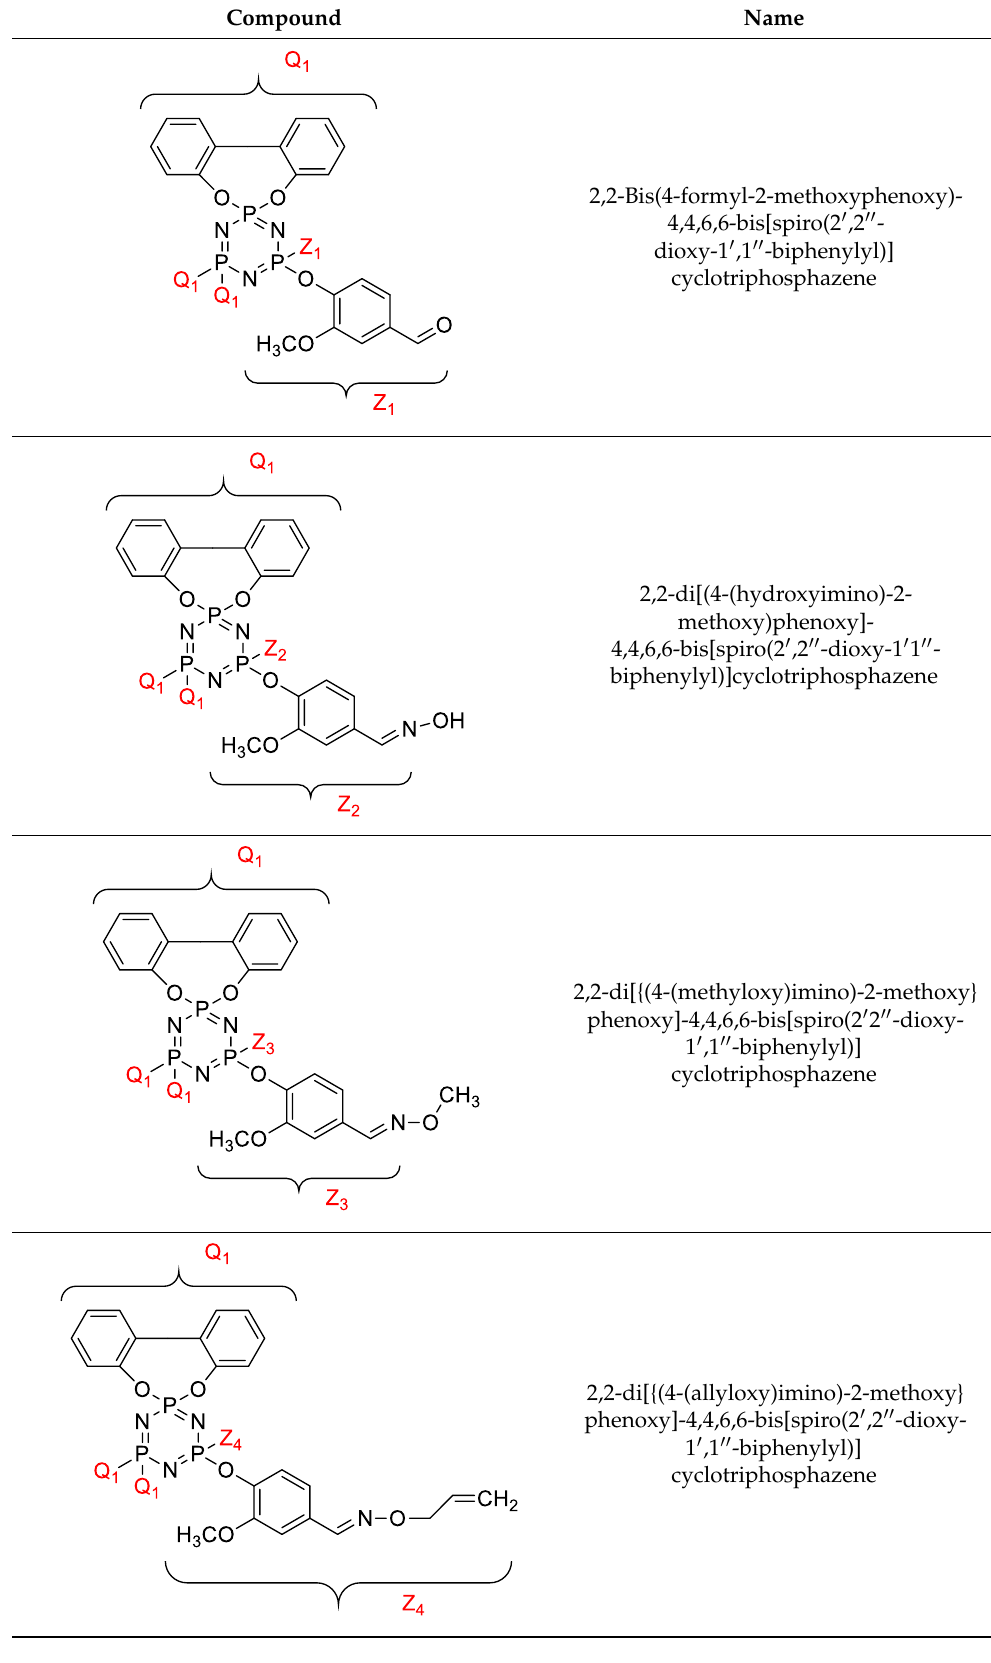
Table 3. Cyclotriphosphazene compound bearing oxime ether and ester as the side group. Compound